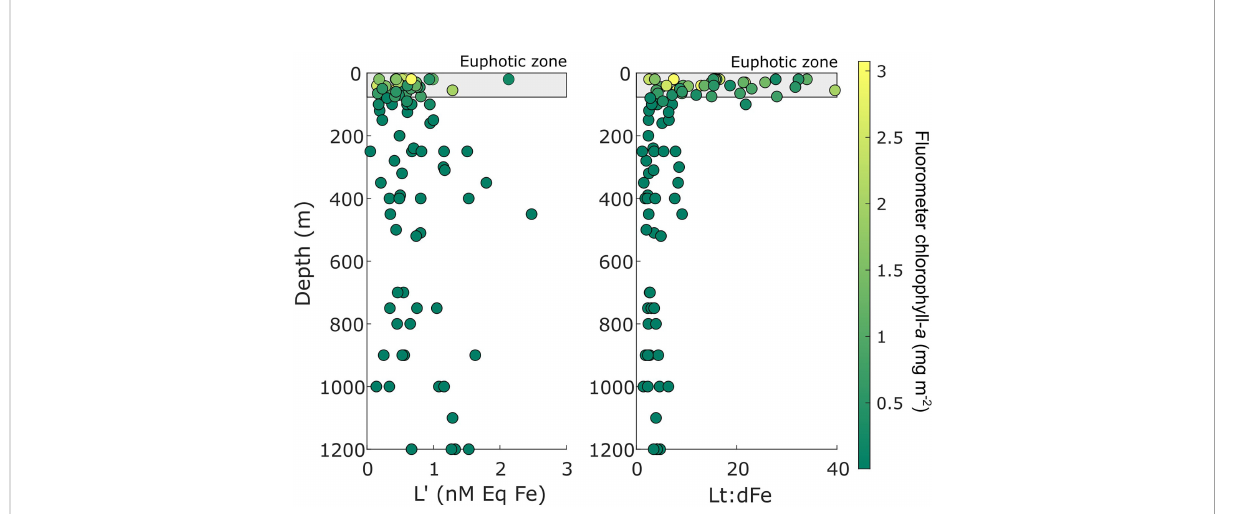
FIGURE 5 Free ligand (L ’ ) and total ligand-dissolved Fe ratio (Lt:dFe) pro fi les from the entire survey, coloured by chlorophyll fl uorescence. Euphotic depth is represented by grey shaded box at a maximum depth of 55